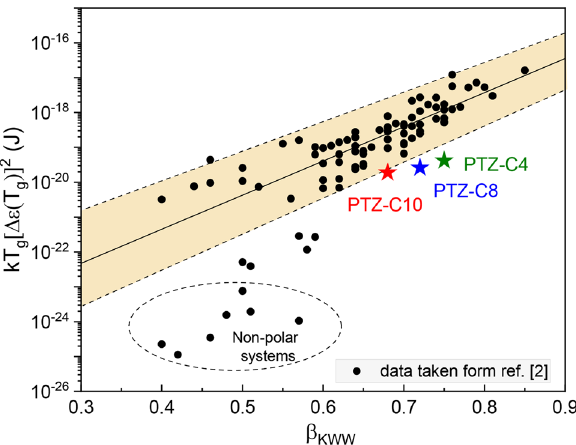
Figure 6. The correlation between kT g [Δ ε ( T g )] 2 and β KWW , a stretching parameter of KWW function 2 . Reprinted with permission from Paluch et al. 2 . Copyright 2016 by the American Physical Society. Data for investigated PTZs have been added (marked as stars), showing that they are not in line with the general